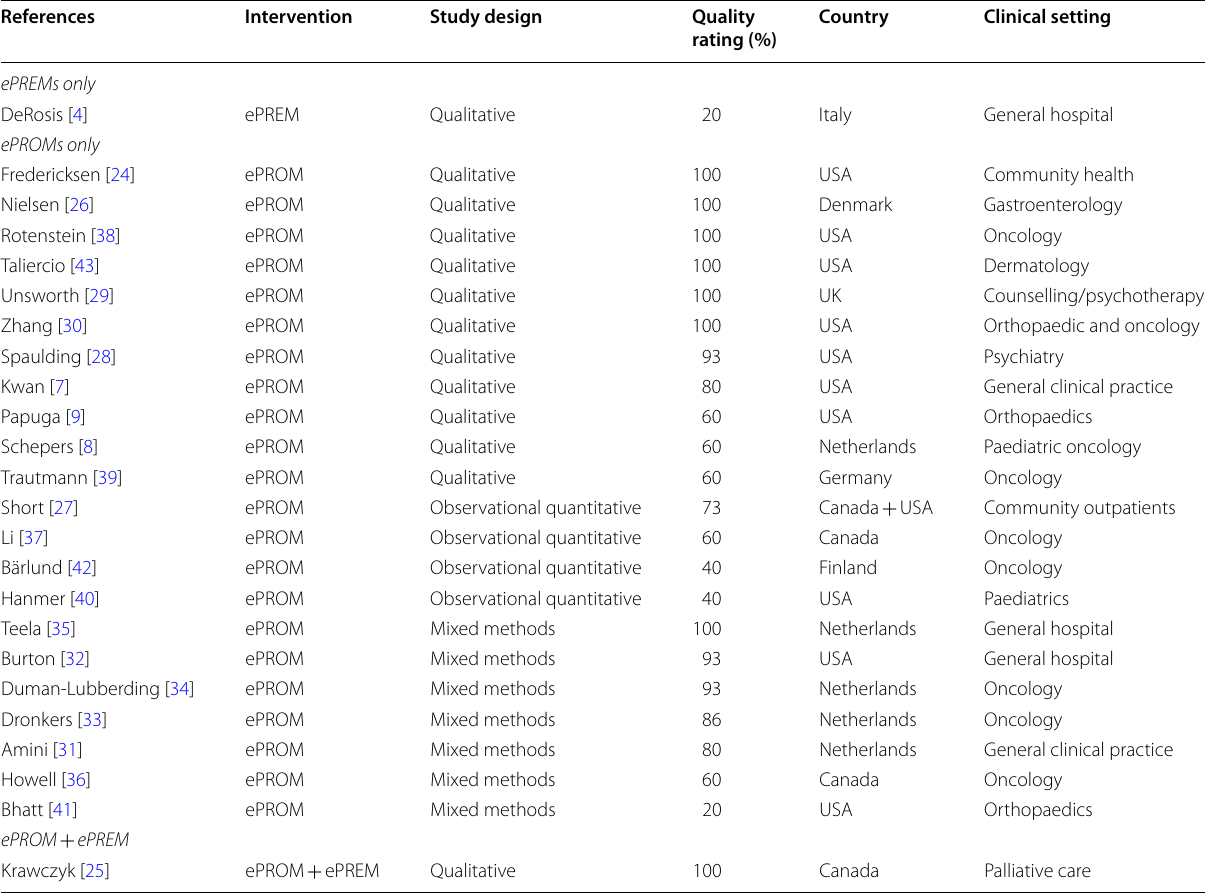
Table 1 Characteristics of included